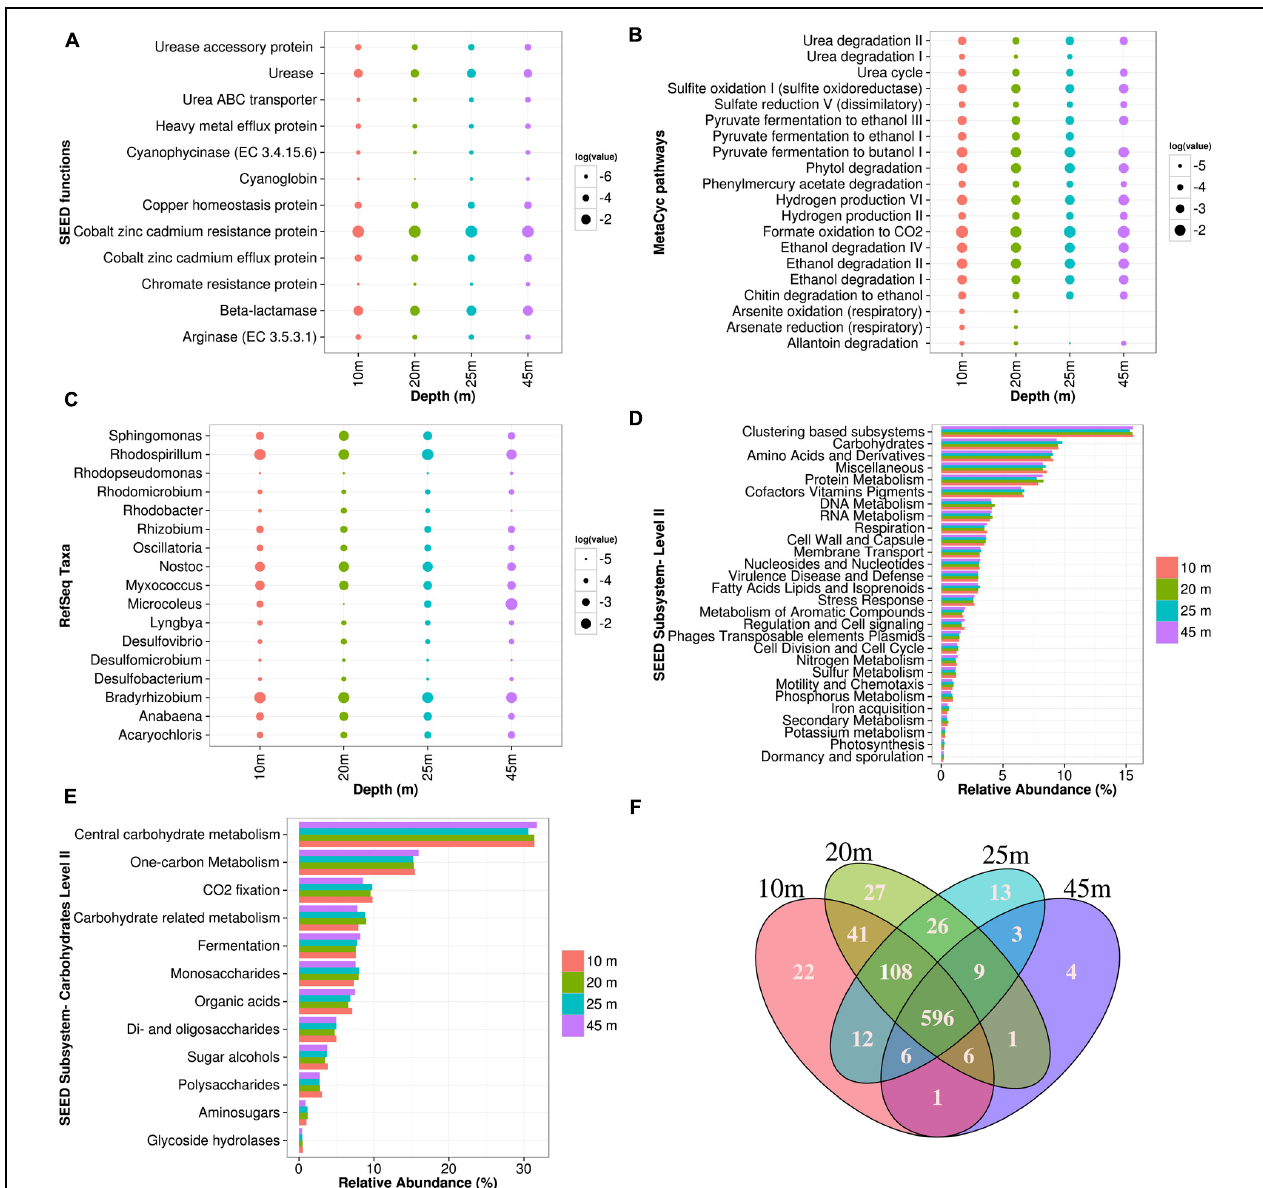
FIGURE 3 | Pavilion Lake microbial community composition and metabolic potential across microbialite morphologies. Microbialite metagenomes are listed as a function of depth in meters. (A) Dotplot of the normalized SEED subsystem functions relating to urea metabolism (e.g., urease, ABC transport), heavy metal detoxification (e.g., efflux, resistance), antibiotic resistance (e.g beta-lactamases), and cyanobacteria related functions (e.g., cyanoglobin, cyanophycinase, copper homeostasis) in log relative abundances. (B) Dotplot of the normalized MetaCyc pathways relating to urea metabolism, sulfite oxidation, dissimilatory sulfate reduction, heavy metal detoxification (e.g., arsenite/arsenate oxidation/reduction, phenylmercury acetate metabolism), hydrogen production, primary alcohol fermentation/degradation in log relative abundances. (C) Dotplot of the normalized RefSeq classifications relating to Alphaproteobacteria, Deltaproteobacteria , and filamentous cyanobacterial genera. (D) Microbialite metagenome functional annotation ranking using SEED subsystem (level I). (E) Microbialite metagenome carbohydrate related SEED subsystem (level II) functional annotations. (F) Venn diagram of the MetaCyc pathway abundances for all the microbialite metagenomes normalized by pathway gene abundances and pathway